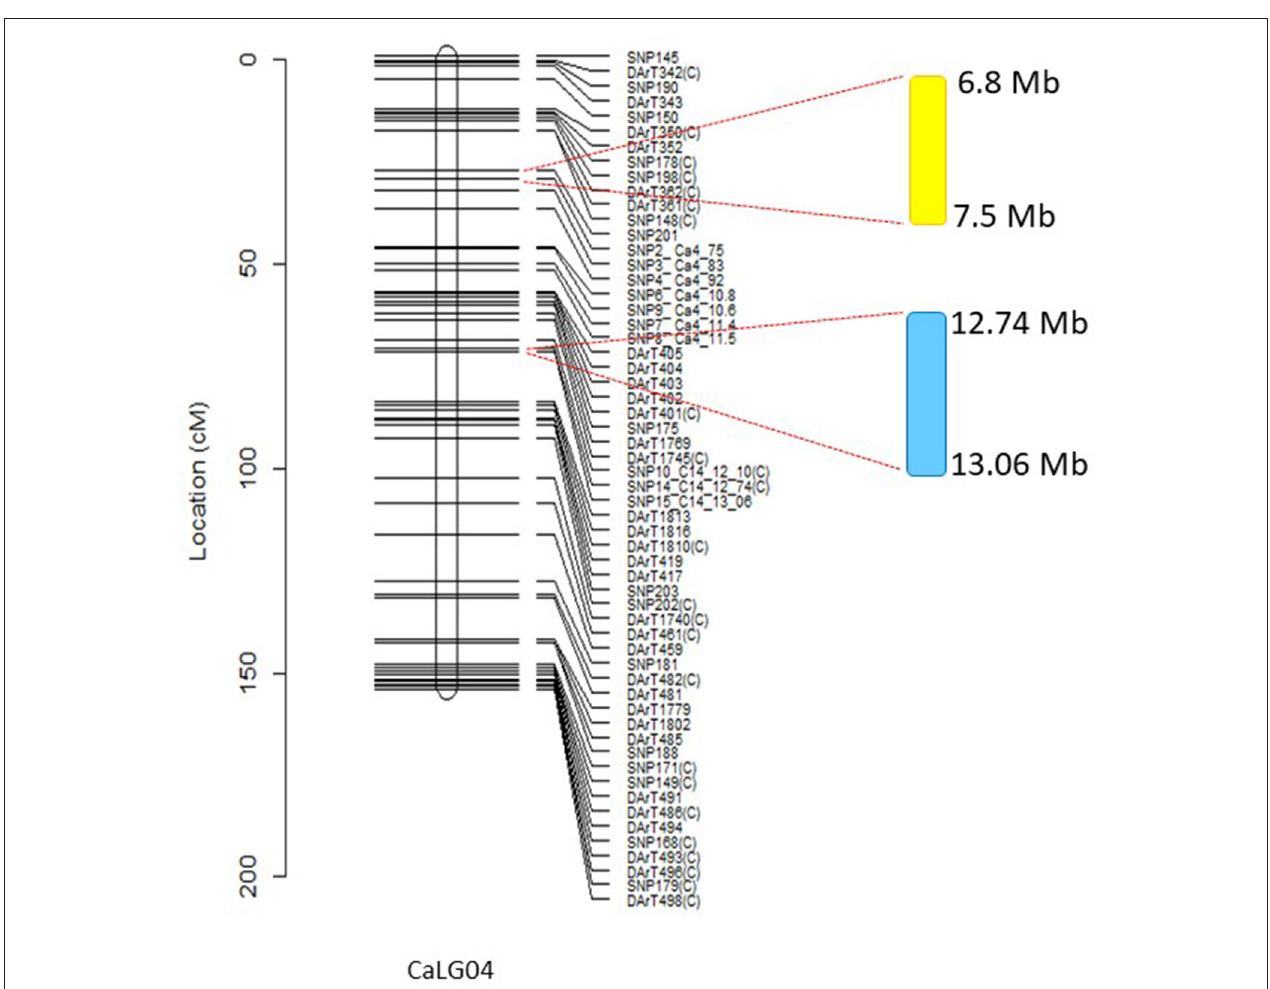
FIGURE 4 | Major salinity and seed yield or biomass-related QTL on CaLG04. Genomic region highlighted in yellow shows the location of multiple salinity-specific QTL associated with necrosis scores and salinity tolerance per se, calculated from residuals from regressions of traits measured in salinity onto corresponding control values. These traits included number of filled pods, seed number, and seed yield. Genomic region highlighted in blue relates to the position of QTL for traits controlling 100-seed weight, above ground biomass, and seed number in both control and salt treatments across different environments. Physical positions of molecular markers flanking the QTLs are provided using the Kabuli reference assembly